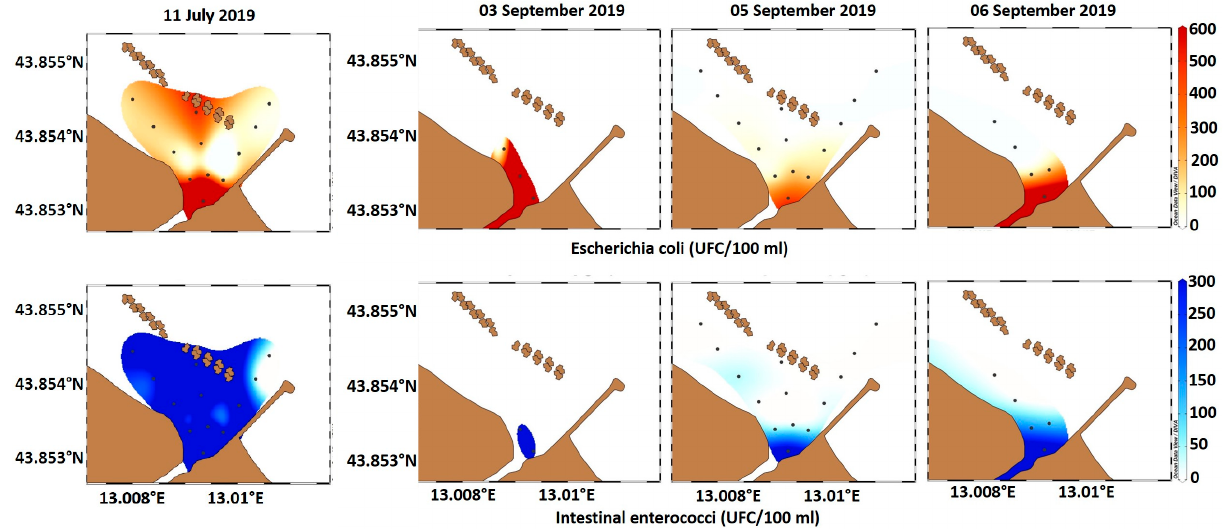
Figure 4. Ocean data view [15] maps showing the spatial distributions of microbial faecal contamination in seawater from sampling stations to offshore along the three transects in front of the Arzilla mouth during the 2019 rainy events (July and September 2019). The graphs show the relative abundance of colony-forming units of Escherichia coli (in red) and intestinal enterococci (in blue).